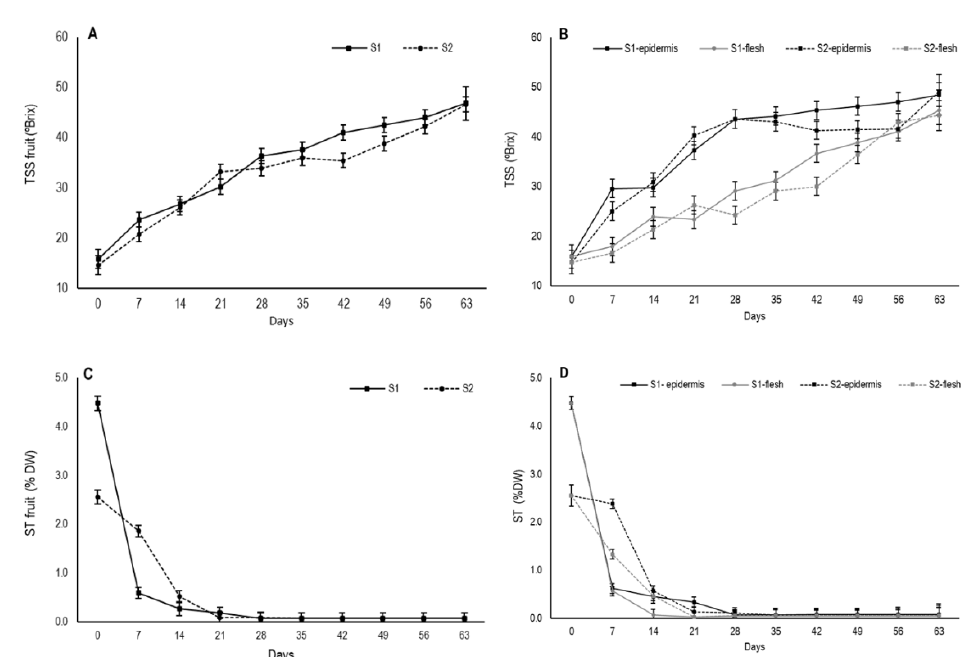
Figure 5. Changes in ( A , B ) total soluble solids (TSS) and ( C , D ) soluble tannins (ST) of whole fruit and by parts (secondary epidermis and internal flesh) during the drying process of persimmon cv. Rojo Brillante in two maturity stages (S1 and S2). Vertical bars represent Least Significant Differences (LSD) intervals ( p ≤ 0.05).